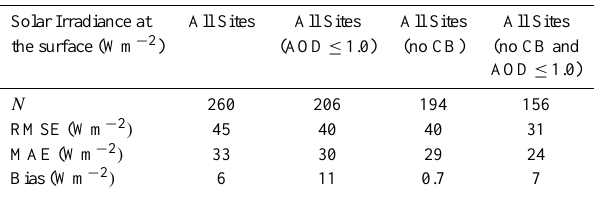
Table 3. Statistics from comparison between model-calculated broadband solar irradiance at the surface and pyranometer measure- ments. Root-mean-square error (RMSE), the mean absolute error (MAE), and the mean bias error are presented.